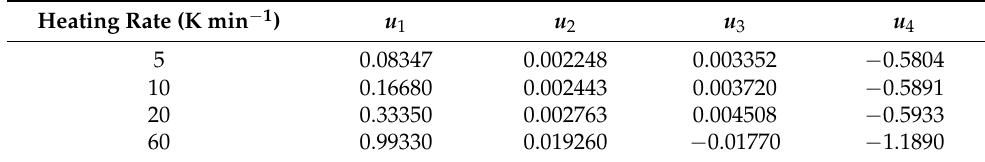
Table 2. Parameters of the exponentially decaying trig function.